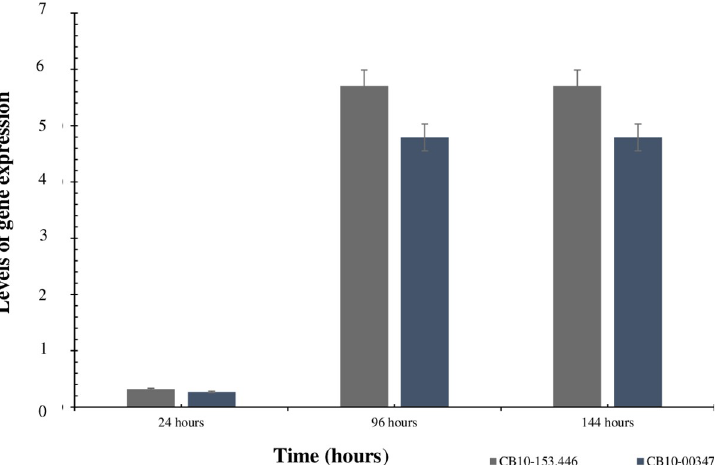
Fig 6. Level of expression of the β -mannosidases genes, respectively associated (CB10-00347) and not associated (CB10-153.446) to PUL-like clusters, calculated using the 2 - ΔΔ CT method for Chitinophaga sp. (CB10) in a liquid BHB culture medium with sugarcane bagasse in relation to endogenous control (SigmaA) and negative enzyme induction (glucose), in the periods of 24; 96 and 144 hours.